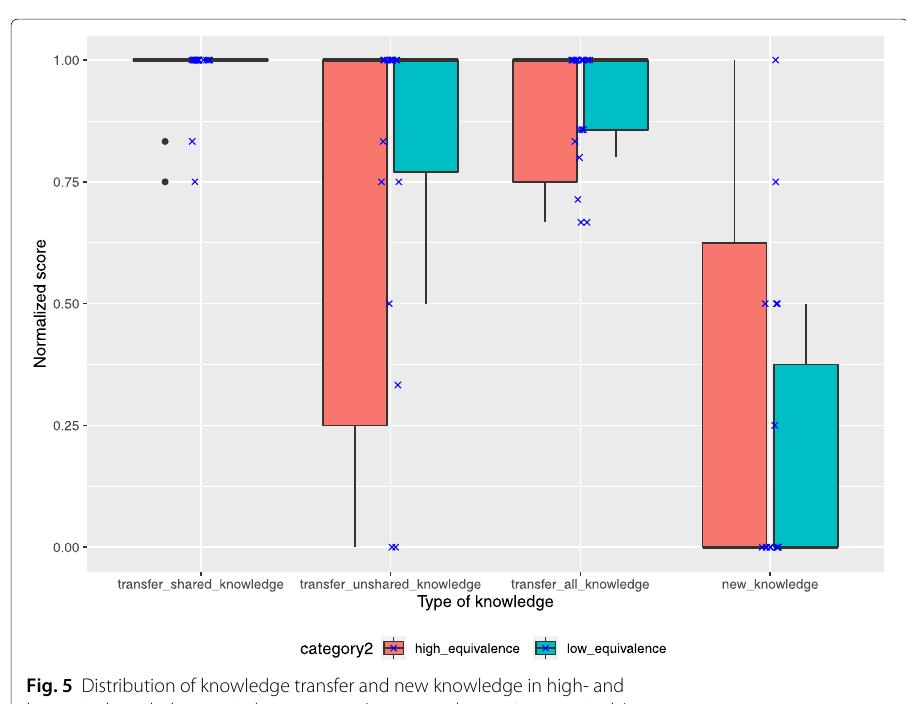
Fig. 5 Distribution of knowledge transfer and new knowledge in high- and low-prior-knowledge-equivalence groups ( n = 11 and n = 10, respectively)